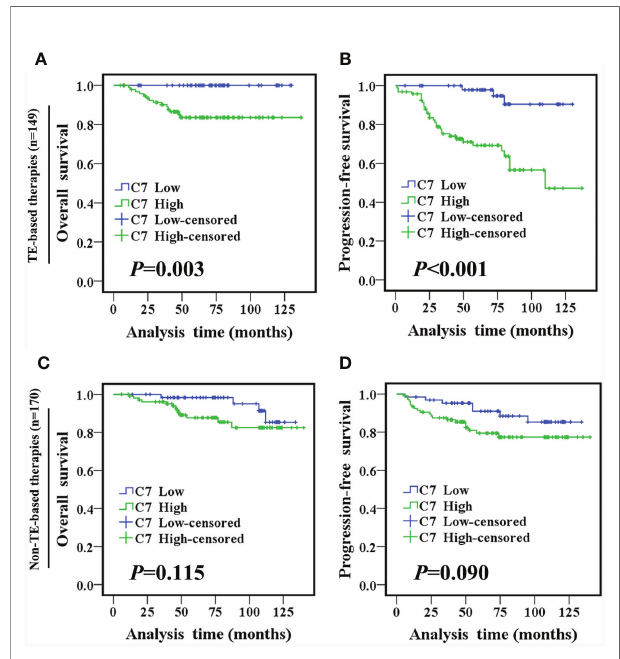
FIGURE 5 | High C7 expression indicated a shorter survival in breast cancer patients treated with TE-based chemotherapy. (A, B) OS and PFS curves of IDC patients treated with TE-based chemotherapy (n = 149). (C, D) OS and PFS curves of IDC patients treated with non-TE-based chemotherapy (n = 170). [ (A – D) log-rank